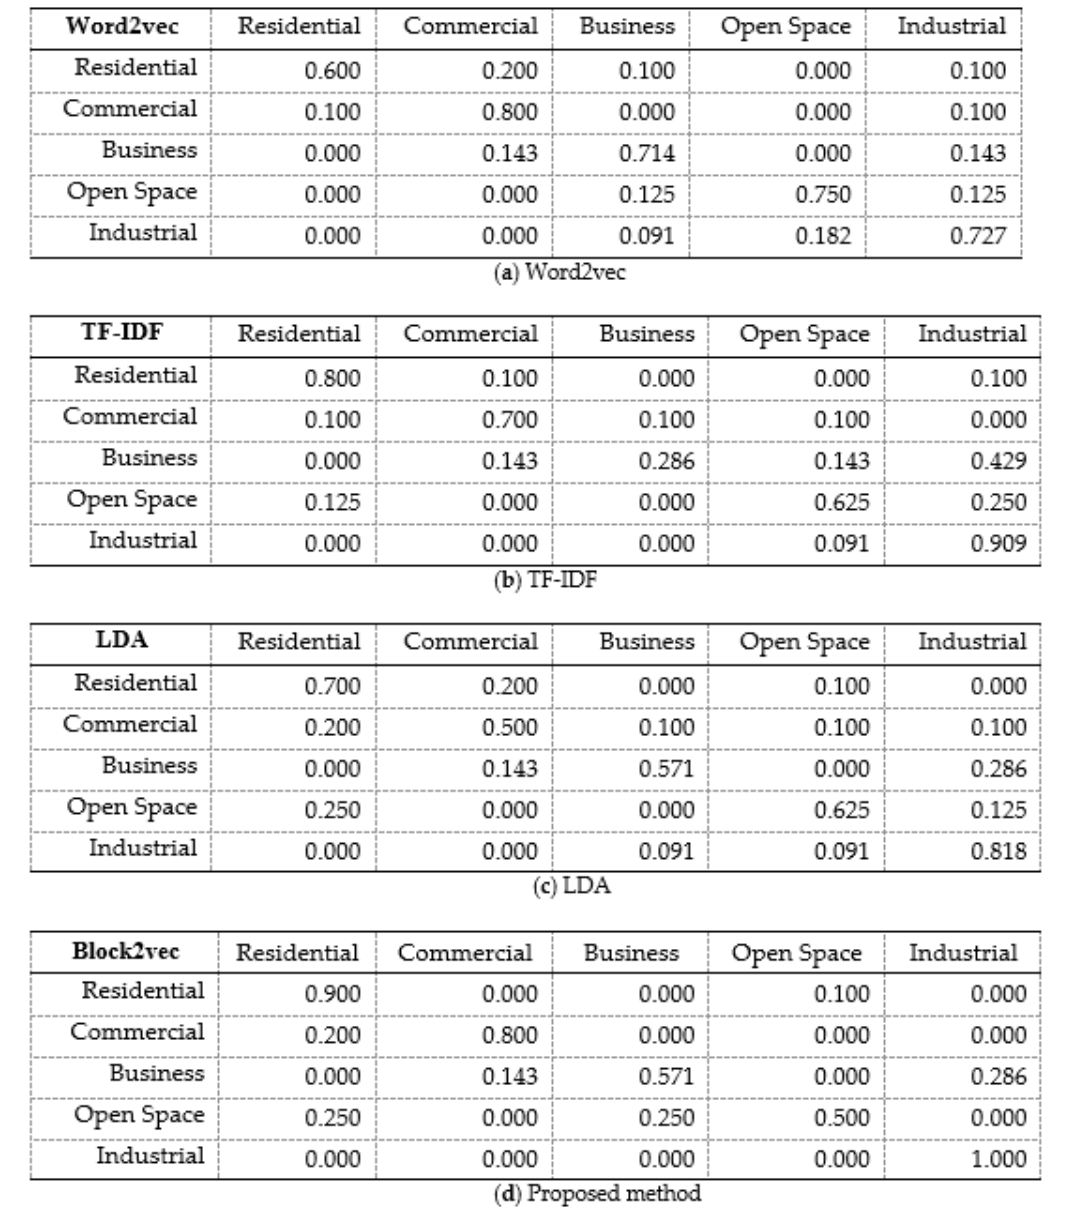
Figure 10. Confusion matrixes of classification results via ( a ) Word2Vec, ( b ) TF-IDF, ( c ) LDA and ( d ) proposed method.